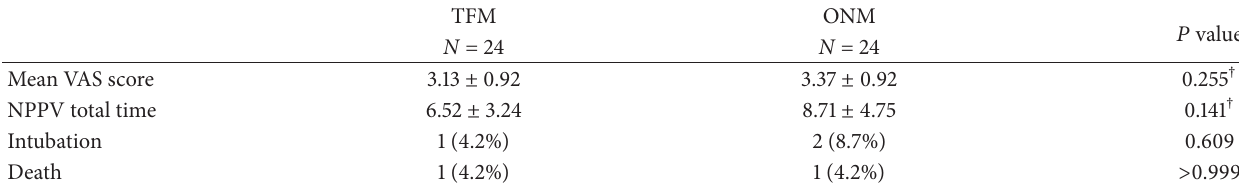
Table 5: Acceptance score, NPPV total time, intubation rate, and mortality rate in the two groups.